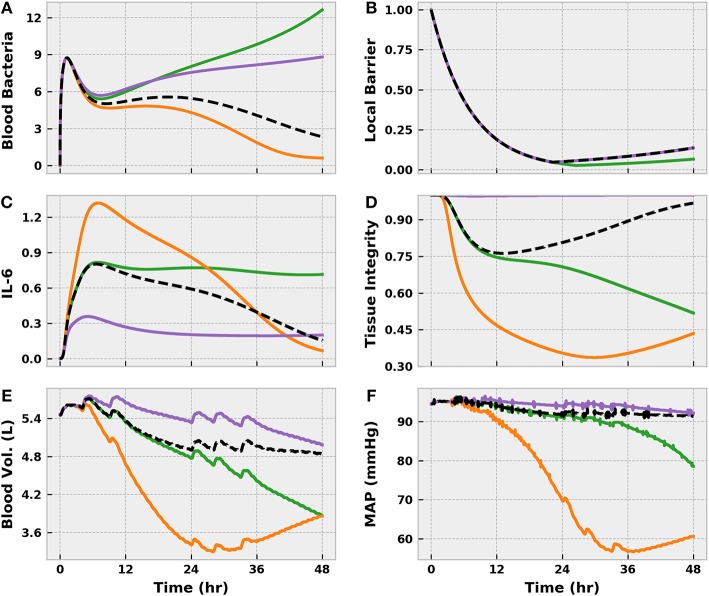
The virtual patients subsets generated by varying acute inflammatory response model parameters in the set {kPTMT, k6M, x66} and applying a Moderate level BioGears infection action. In the nominal case (Black), pathogen is eliminated (A) and pro-inflammatory mediated tissue damage is minor (D), as evidenced by slight fluid shift (E) and minimal MAP change (F). Decreasing φPM creates a “Susceptible” population (green), which allows bacteria buildup at the site of infection and prolongs activation of the TLR switch. Enhanced TLR activity favors local barrier degradation (B) to promote neutrophil migration to the infection site, but this action also promotes excessive bacteria diffusion to the bloodstream, leading to sepsis. Increasing k6M and x66 generates a “Hyperinflammatory” response (orange), in which the bacteria is eliminated, but interleukin-6 levels remain elevated (C). This imbalanced pro-inflammation leads to tissue damage (i.e., endothelial barrier damage) that causes vascular volume shift. Finally, decreasing k6M and x66 creates an “Immunosuppressed” patient (purple). Interleukin-6 levels remain low, characterizing a pro-inflammatory phase insufficient to eliminate bacteria in the blood. Though tissue damage does not accumulate, the patient will no doubt experience consequences of systemic infection.